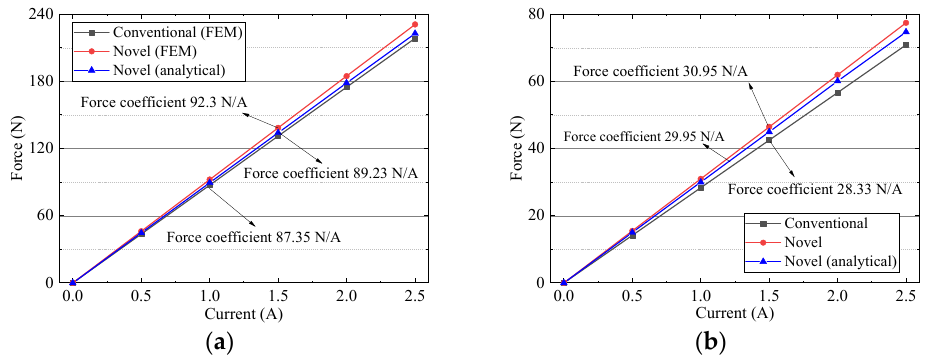
Figure 21. Driving force versus current: ( a ) horizontal coil ( b ) vertical coil.